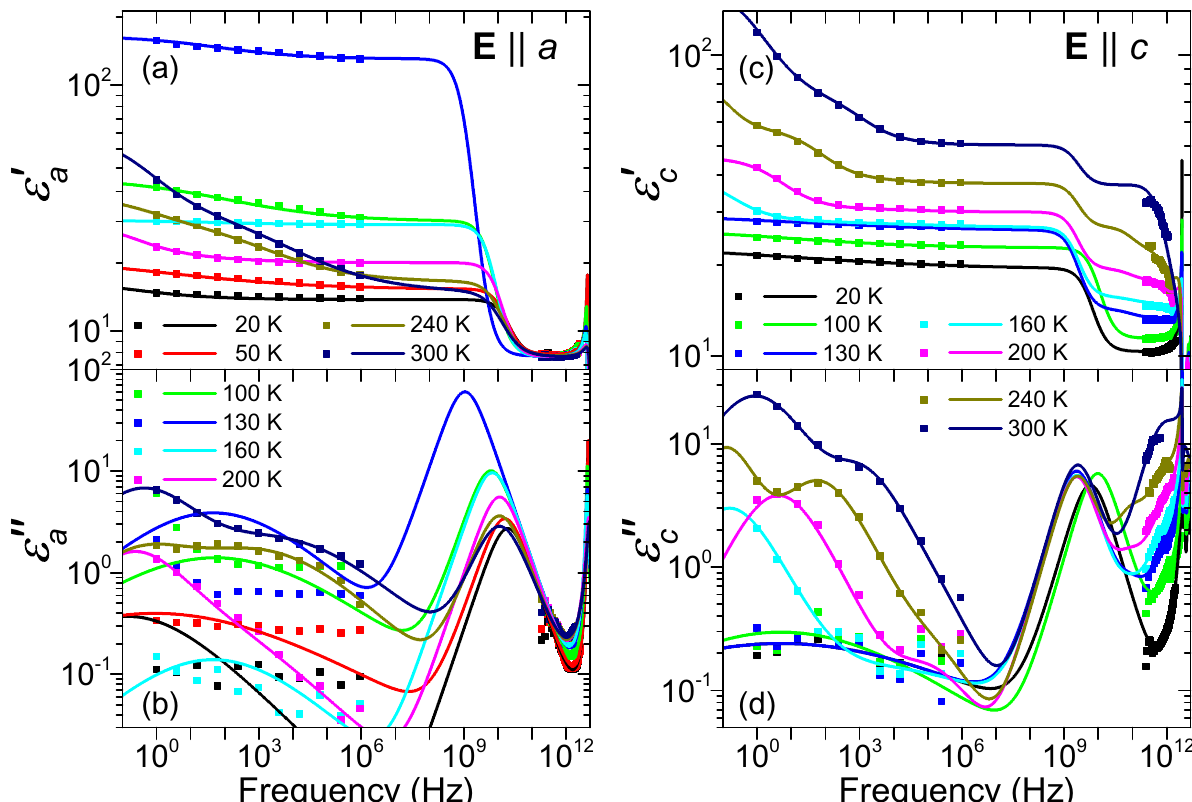
Figure 5. Broadband fits of complex permittivity ˆ ε a ( a , b ) and ˆ ε c ( c , d ) of lawsonite as a function of temperature. Symbols: experimental values obtained by impedance (selected frequencies) and THz spectroscopies; lines: fits using Eq. (4). The estimated precision of the complex permittivity values is ± 3%